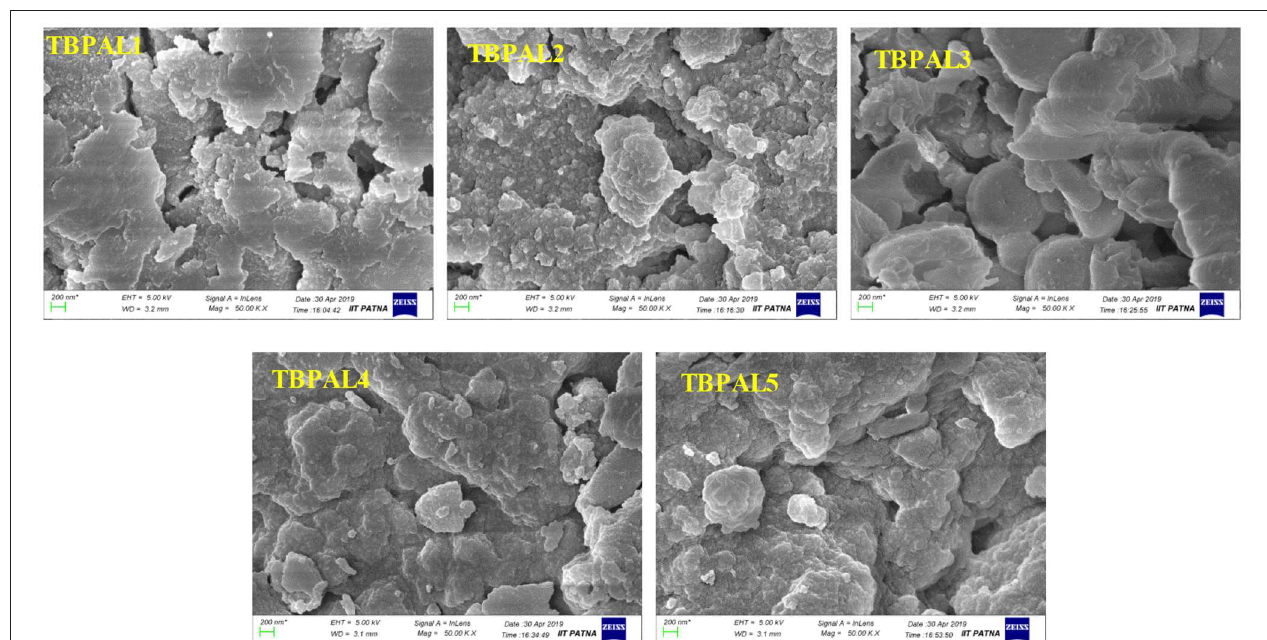
FIGURE 3 | FESEM images of TBPALs